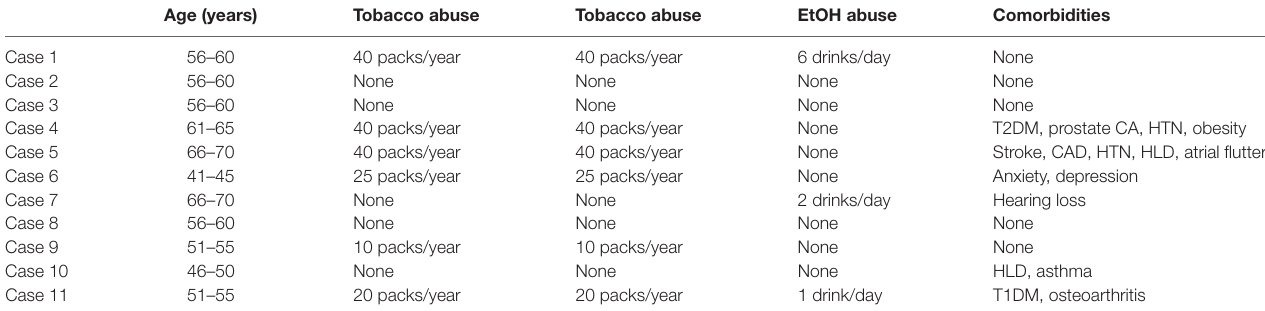
Table 1 | Patient demographics and comorbidities.